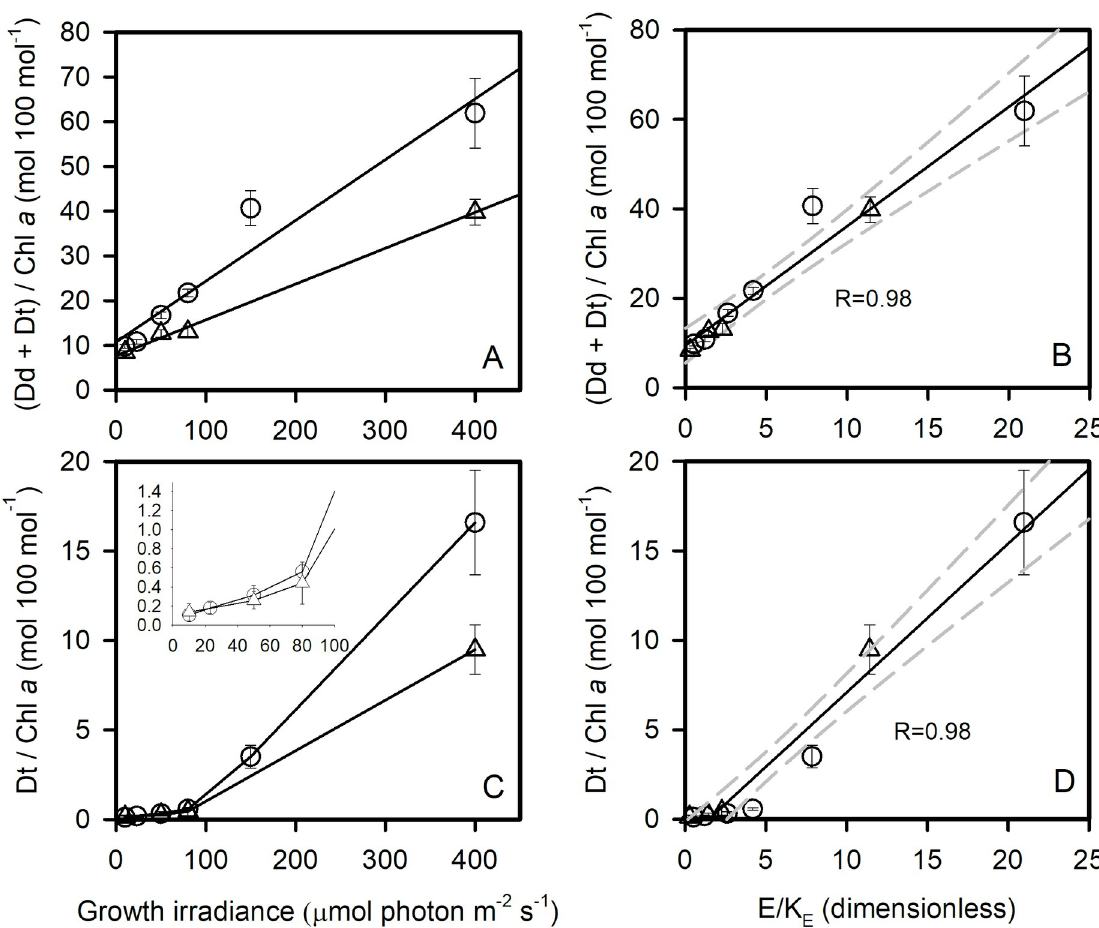
Fig 4. Effect of the acclimation irradiance on the xanthophyll cycle of C . neogracilis . (Dt +Dd)/Chl a (A) and Dt / Chl a (C) versus growth irradiance at 0˚C (circles) and 5˚C (triangles). (Dt +Dd) / Chl a (B) and Dt / Chl a (D) versus E/K E at 0˚C (circles) and 5˚C (triangles). In C an insert shows an enlargement of low irradiances. Each data point is the mean of 3 cultures measured each day during 3 consecutive days (23, 50, 80, 150, 400 μ mol photon m -2 s -1 ) or 2 days (10 μ mol photon m -2 s -1 ). Error bars represent standard deviations.